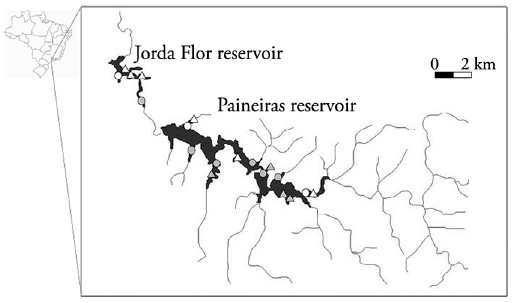
Figure 1. Location of the reservoirs in Brazil and position of the sampling sites in dry (circles) and wet seasons (triangles). Light gray symbols indicates sites with ripar- ian